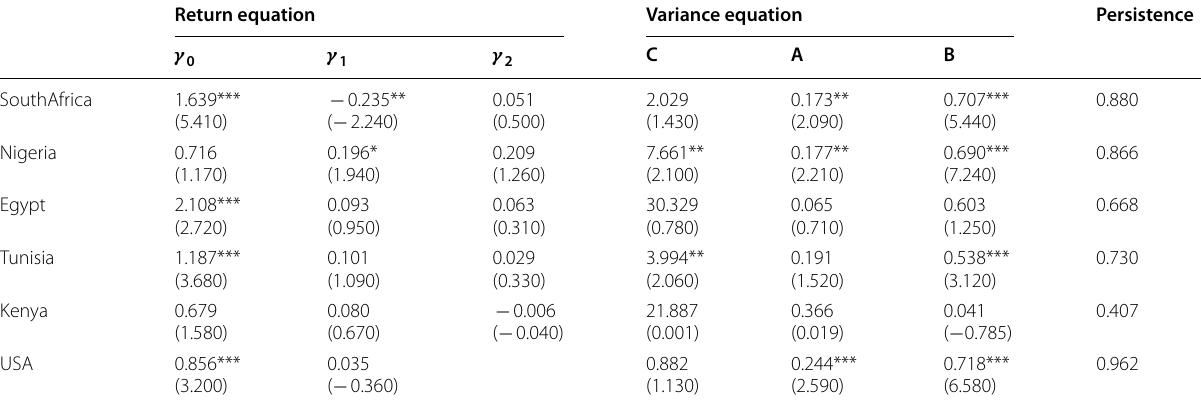
Table U.S. represents U.S. stock returns. The persistence level of the variance is calculated as the summation of the coefficients in the variance equations ( A statistics are in parentheses. ***, **, and * denote statistical significance at the 1%, 5%, and 10% levels with critical values of 2.58, 1.96, and 1.65, respectively